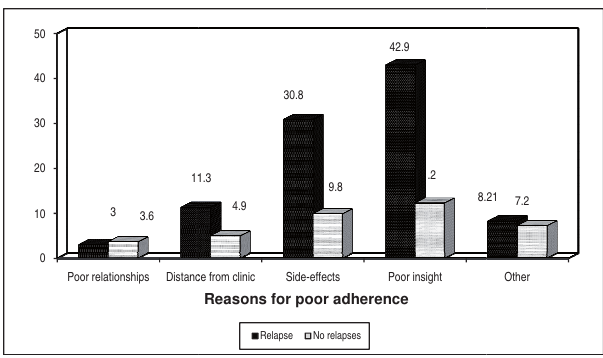
Fig. 1. Reasons for poor adherence in the study population.